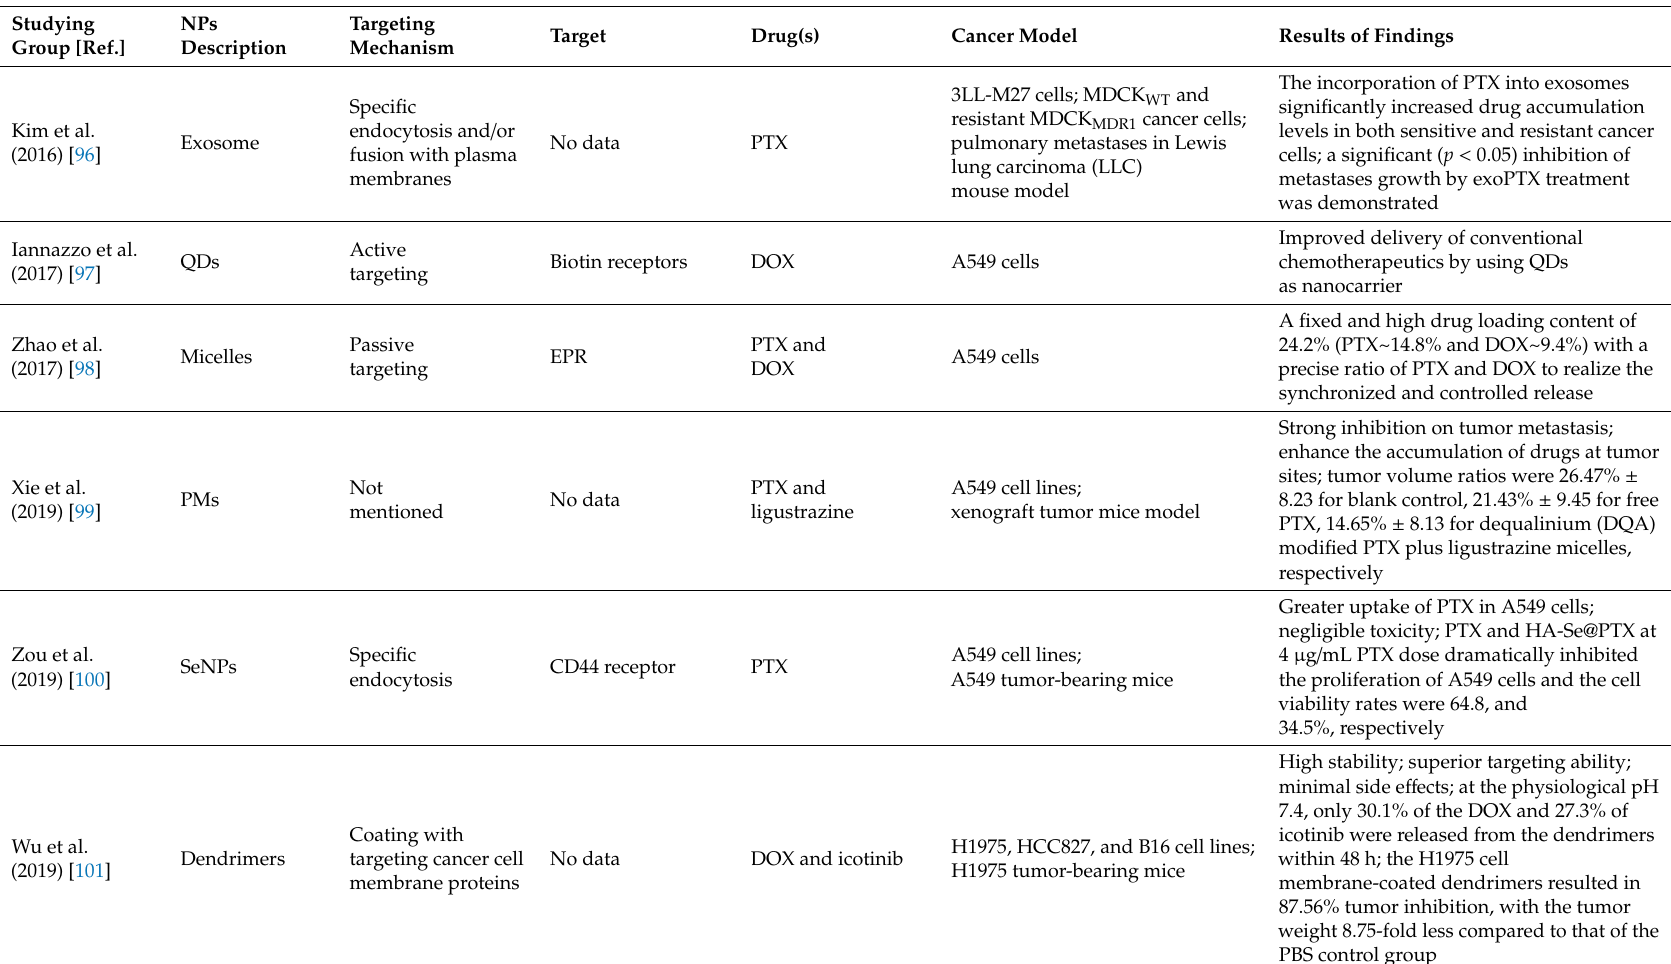
Table 2. A brief summary of the application of nano-based DDS in selected